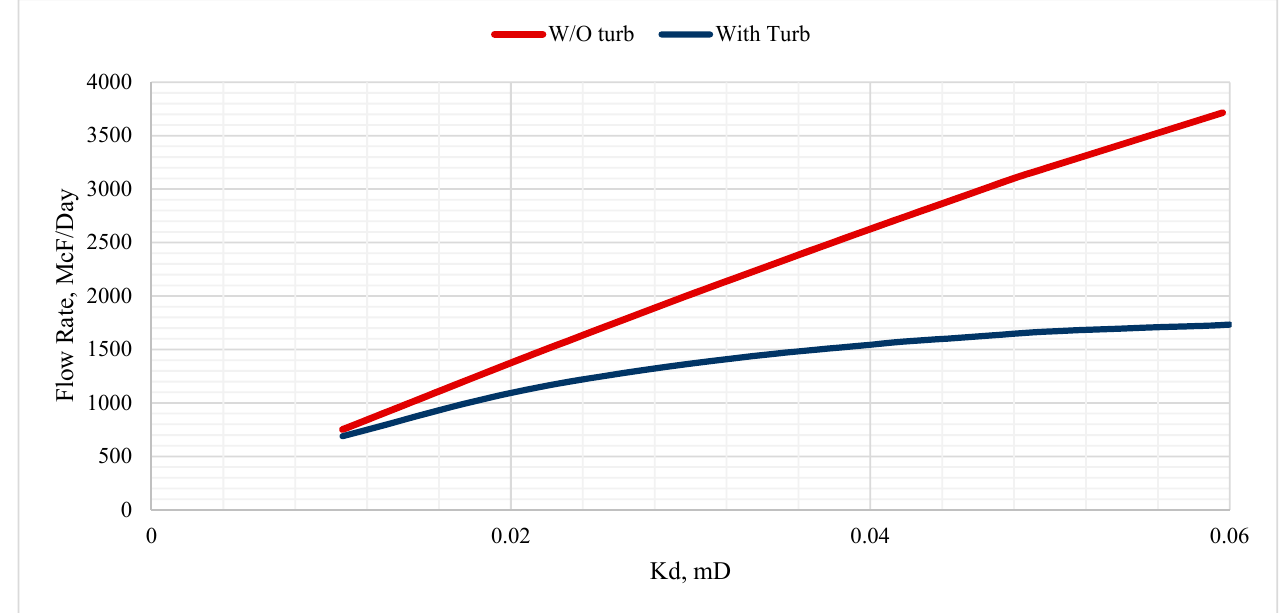
Figure 9. Gas flow rate versus damaged zone permeability.